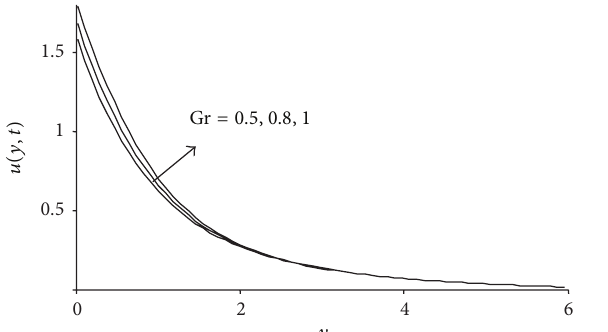
Figure 2: Velocity profiles for Pr eff = 0 . 350 ( 𝑁 𝑟 = 1, Pr = 0 . 7), 𝐾 𝑝 = 0 . 7, 𝑡 = 1 . 2, and different values of Gr when the plate applies constant shear stress 𝑓 = − 0 . 25.